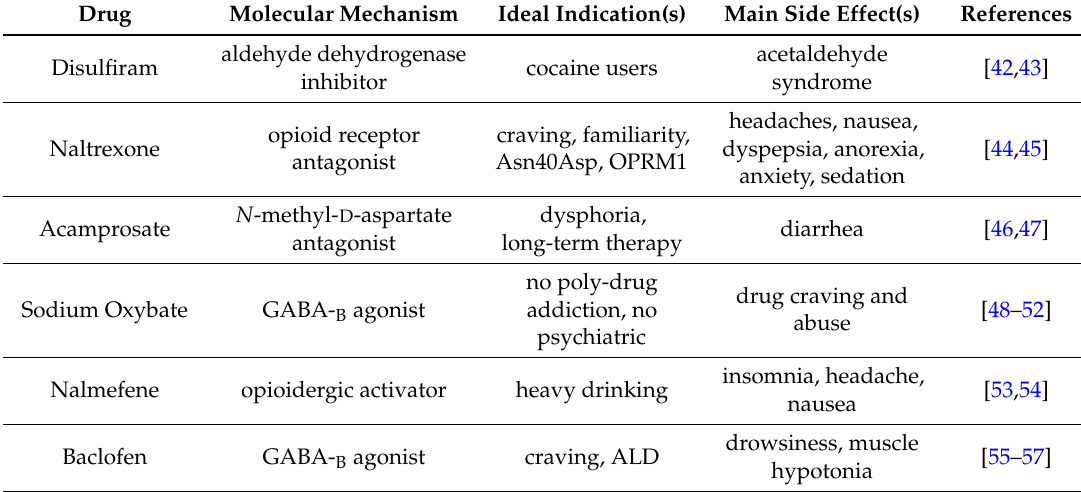
Table 2. Pharmacological options for patients with